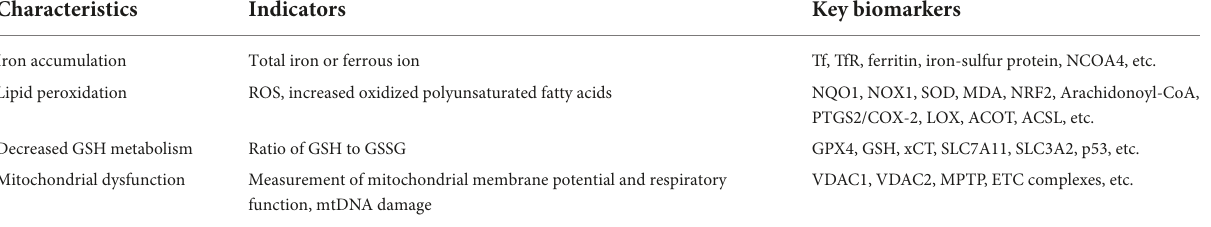
TABLE 1 Major regulatory indicators and potential markers of